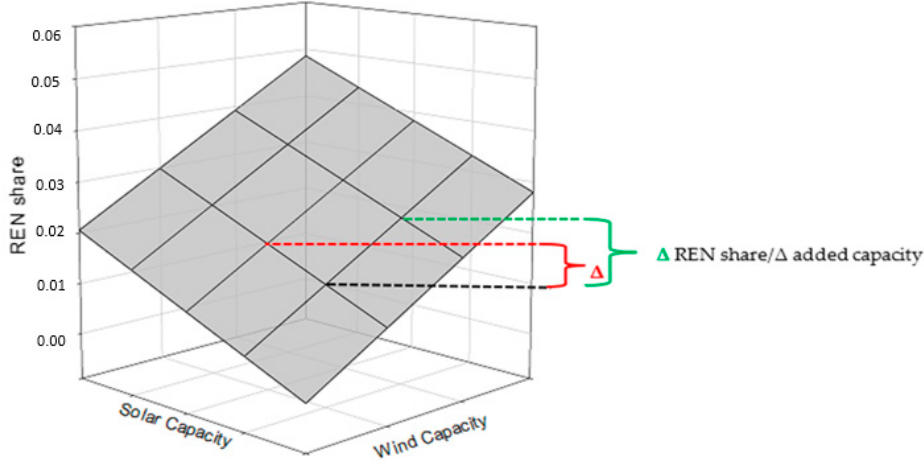
Figure 3. Illustration of the incremental evaluation of additional capacity from either wind or solar PV on the REN share surface plot with higher gradient for wind compared to solar PV (red: REN share delta solar PV, green REN share delta wind).